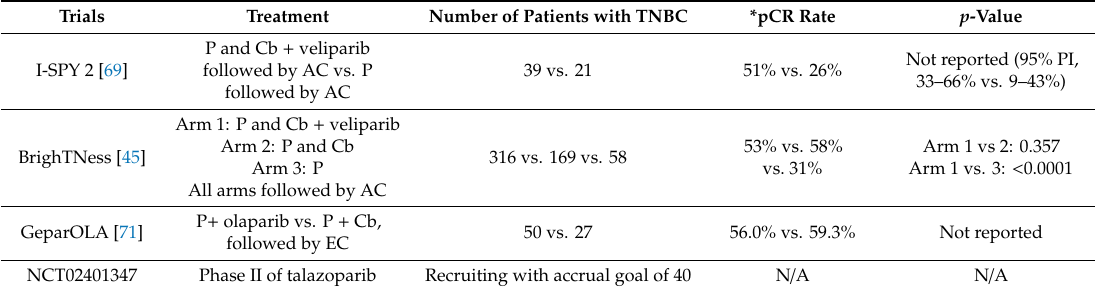
Table 4. Poly-ADP-ribosyl polymerase (PARP) inhibitors in neoadjuvant TNBC